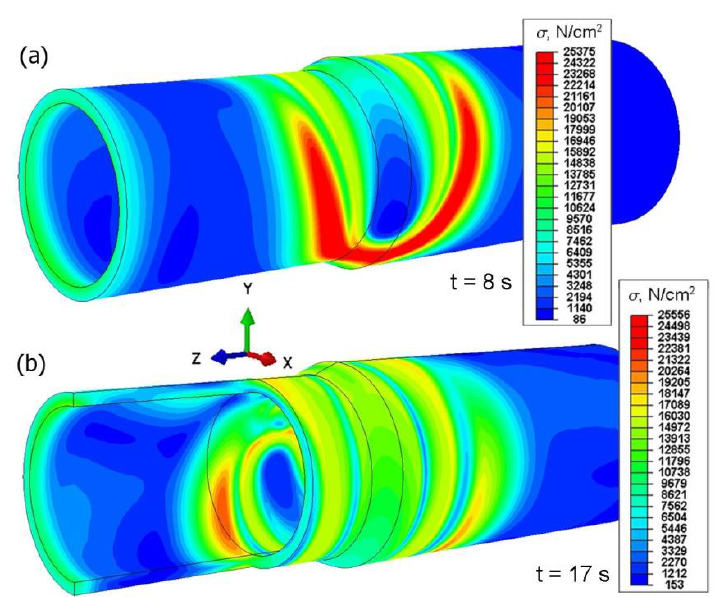
Figure 18. Temporary reduced stresses of a welded joint for two different simulation times, t = 8 s; t = 17 s.